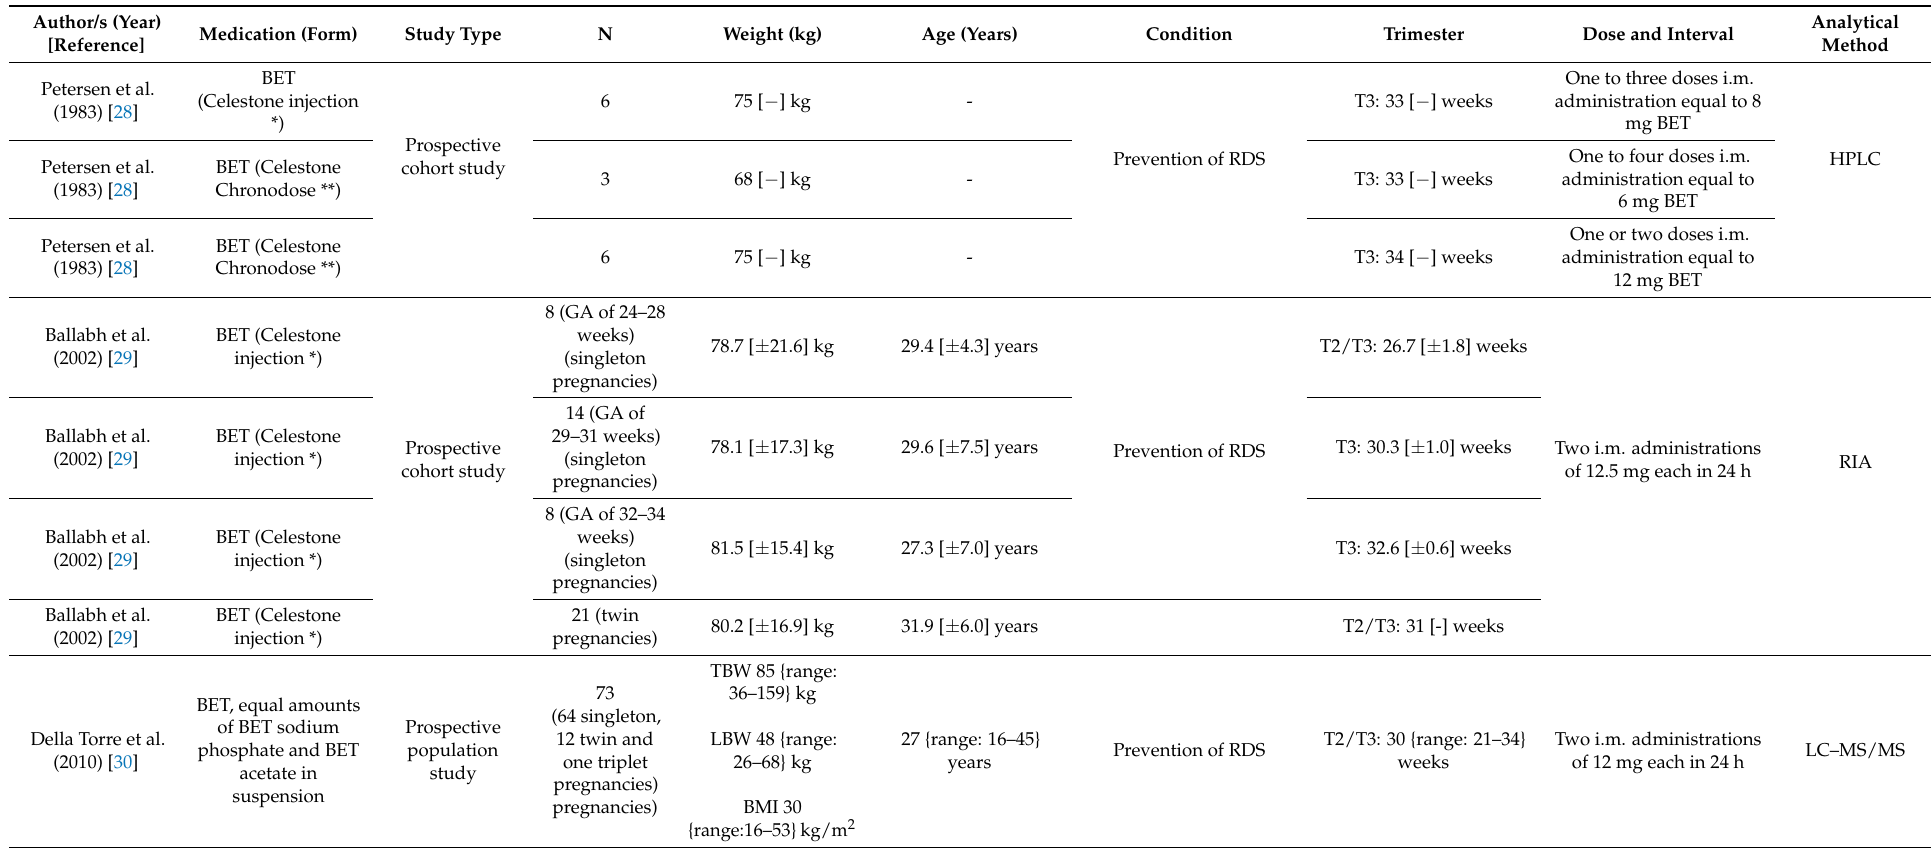
Table A3. Patient and study characteristics of the included studies in this systematic review. The data are presented as mean (SD), median (IQR) or alternative method, indicated next to the corresponding value. Each row is dedicated to one medicine. When a column overlaps multiple rows, the data are shared over multiple